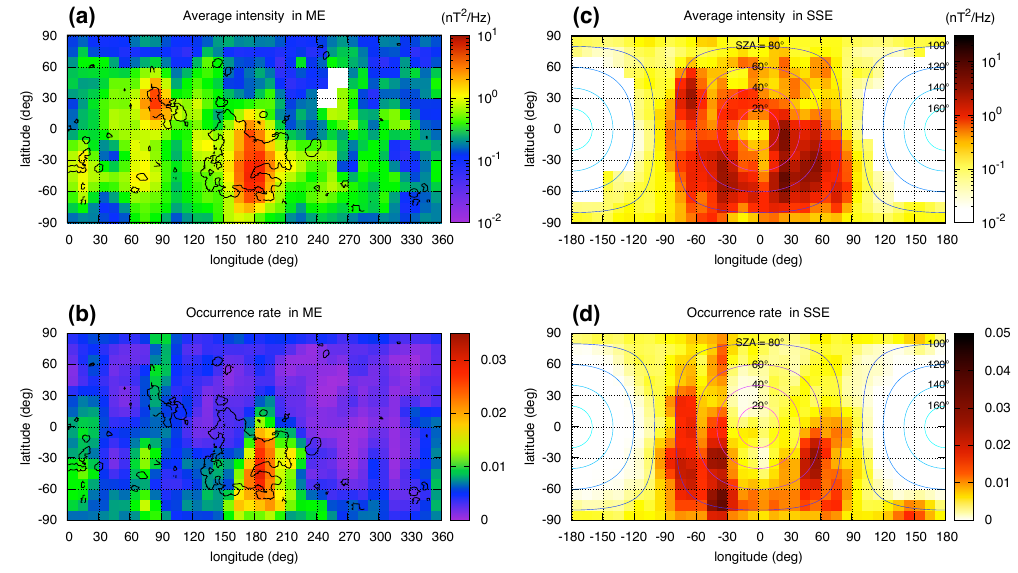
Fig. 2. Distributions of (a) average intensity and (b) occurrence rate of the monochromatic whistler waves in the selenographical (Mean Earth/polar axis, ME) coordinates with 20nT of surface magnetic field strength contour (same as Fig. 1f) and (c) average intensity and (d) occurrence rate of the waves in the Selenocentric Solar Ecliptic (SSE) coordinates with SZA contours shown for every 20 ◦ . The average intensity is calculated by dividing the sum of the peak intensities of the waves by the number of events in each 10 ◦ × 10 ◦ bin. The occurrence rate is obtained by dividing the number of events by the number of 16s interval data points for all orbits in each 10 ◦ × 10 ◦ bin. SSE longitude corresponds to local time (e.g., 0 ◦ longitude in SSE corresponds to local noon), SSE latitude almost corresponds to selenographical latitude because of the small (a few degrees) inclination of the Moon’s